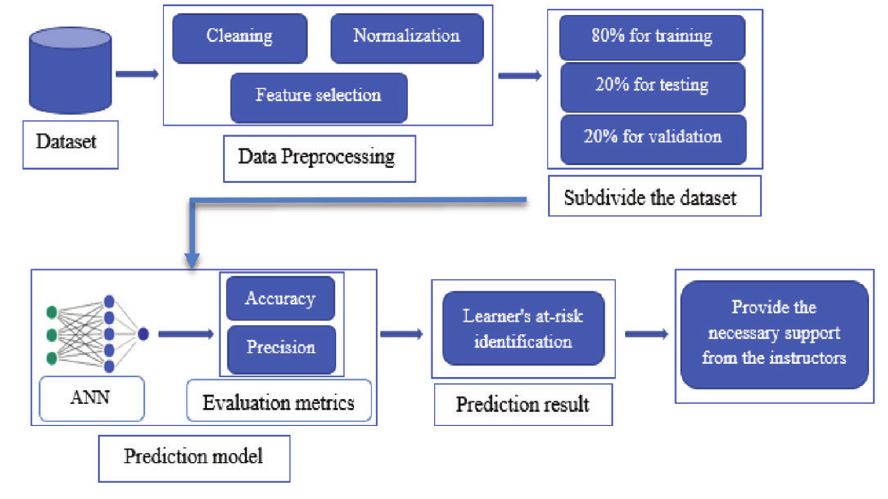
Fig. 1. Workflow of our predictive